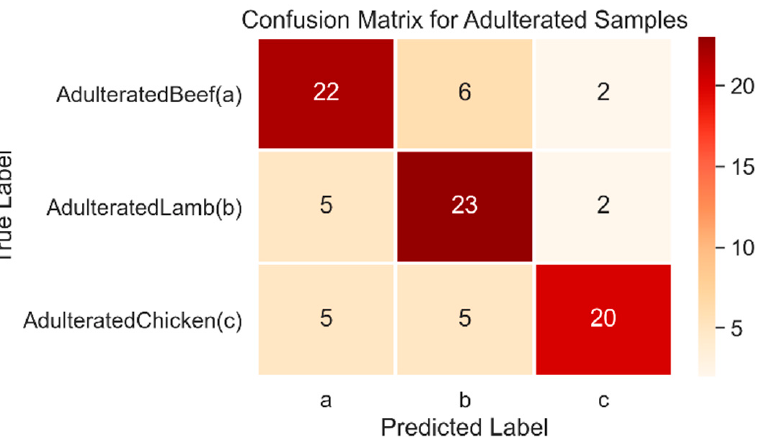
Figure 8. Heatmap confusion matrix of the multiclass SVM classifier for adulterated samples of beef, chicken, and lamb.